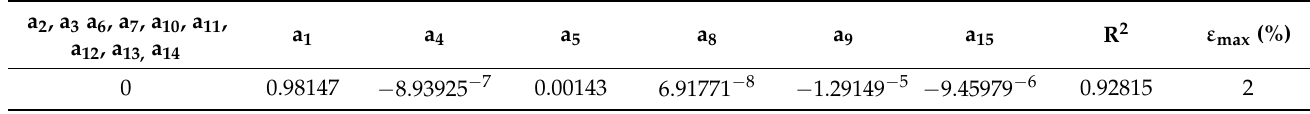
Table 5. Regression coefficients for cracked cylindrical shell with clamped support ( L / R = 20, R / T = 25).